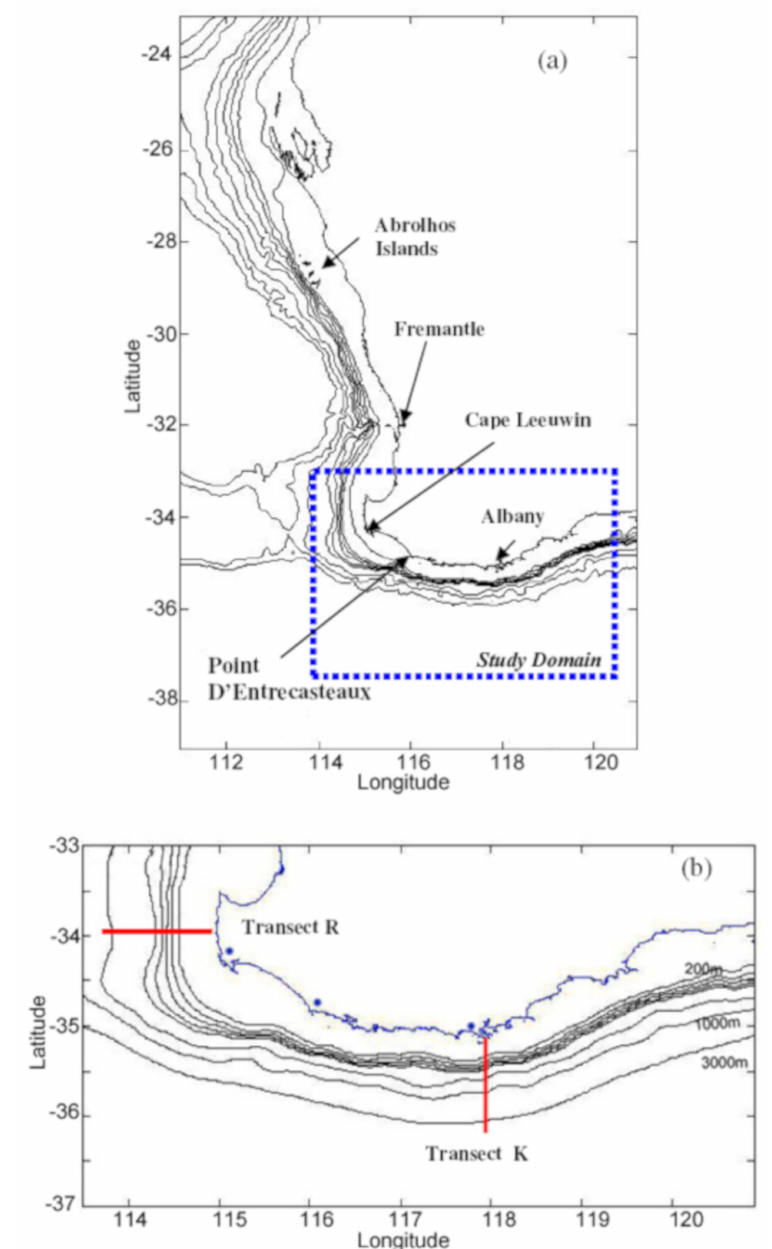
Figure 1. ( a ) Model domain with bathymetry contour lines with specific name of places that will be referred throughout the paper. ( b ) The study area overlaid with the field transect of the Southern Surveyor cruise SS04 / 06. The current system was